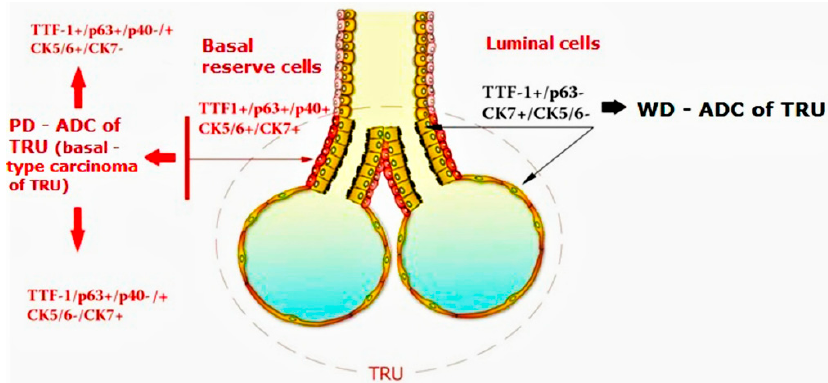
Figure 5. On the right, the scheme illustrates the origin of well-differentiated adenocarcinoma (WD-ADC) from the superficial epithelial cells of the alveolar and bronchiolar lining of the terminal respiratory unit (TRU) (in yellow). On the left is shown the hypothesis about the origin of solid, TTF1+/p63+/p40+/ − poorly differentiated adenocarcinoma (PD-ADC) from the basal reserve cells of the TRU (in red), coexpressing p63, TTF-1 and, in rarer cases, p40.